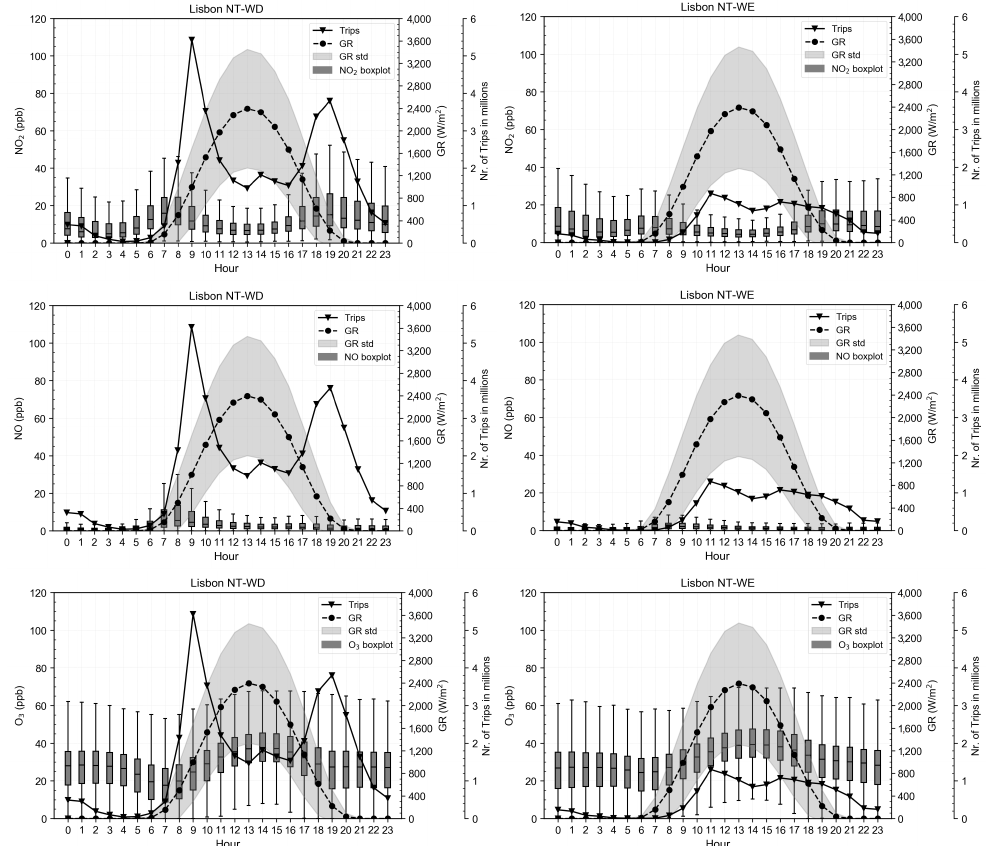
Figure 12. Mean values of all years data. Lisbon Traffic (T) AQMS comparison of WD ( left ) and WE ( right ) for NO 2 , NO, and O 3 (top to bottom